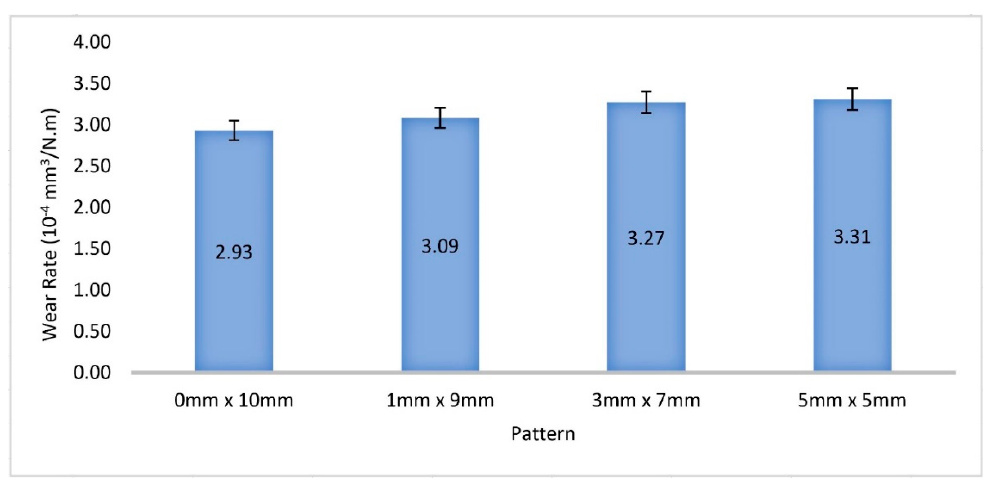
Figure 11. Mean volumetric wear of Ti-6Al-4V ELI alloy discs tested over 5000 cycles against alumina balls using Ringer’s solution as lubricant.